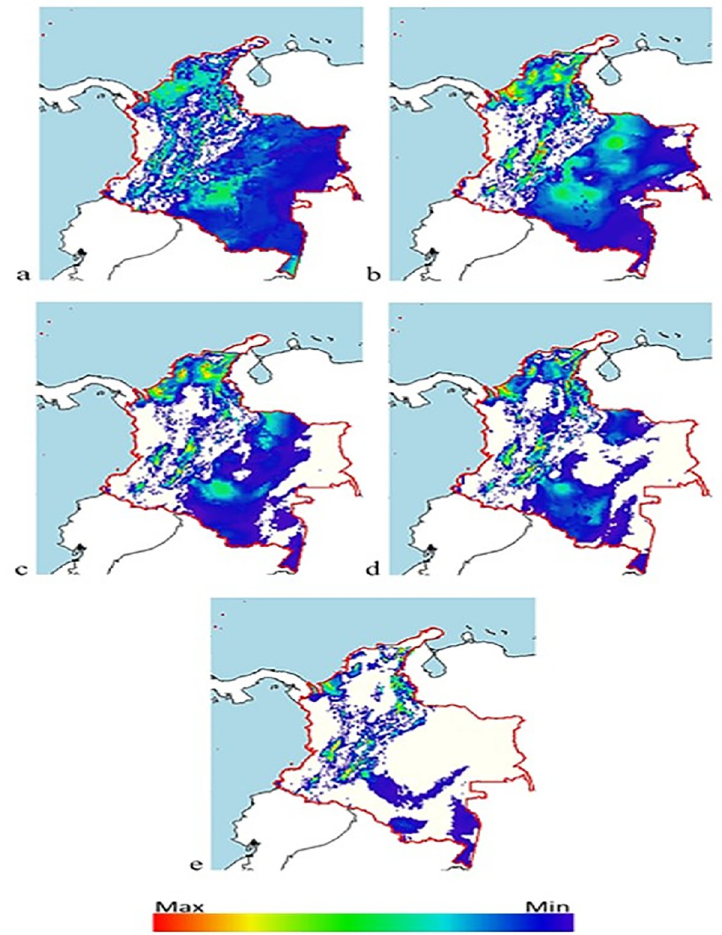
Fig 11. Distribution of Diatraea spp. in Colombia under different climate change (BCC-CSM1-1) and carbon concentration projections over 70 years. a) current condition, b) rcp26, c) rcp45, d) rcp60, e) rcp85. The color chart indicates maximum or minimum presence in a likely niche under favorable